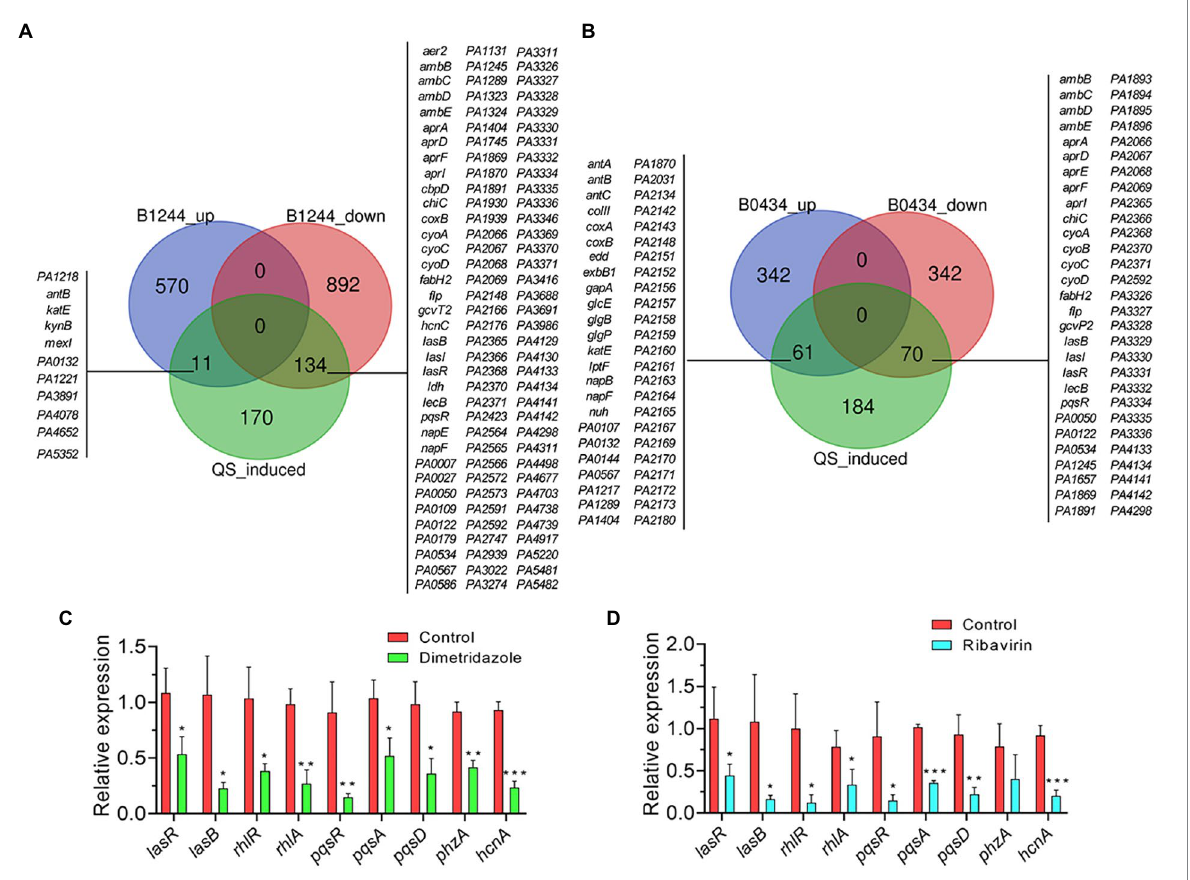
FIGURE 6 Effects of Dimetridazole and Ribavirin on the expression of QS-induced genes in Pseudomonas aeruginosa PAO1. (A) Number and list of significantly differentially expressed QS-induced genes in Dimetridazole-treated P. aeruginosa PAO1. (B) Number and list of significantly differentially expressed QS-induced genes in Ribavirin-treated P. aeruginosa PAO1. B1244, Dimetridazole. B0434, Ribavirin. Expression of typical QS-induced genes in (C) Dimetridazole-and (D) Ribavirin-treated P. aeruginosa PAO1 as determined by quantitative PCR. Data shown are the means ± SD of three independent experiments. Unpaired two-tailed t test, * p < 0.05, ** p < 0.01, *** p <